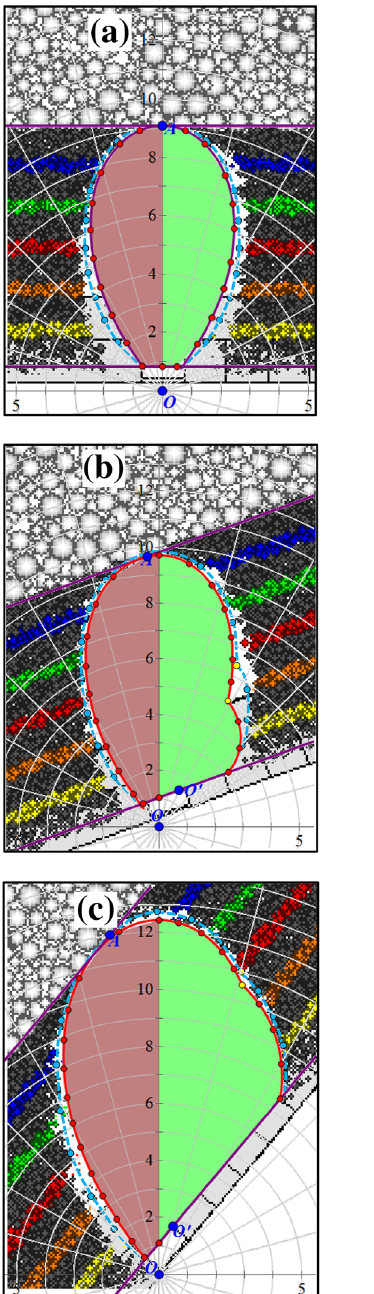
Fig. 12 Comparison of theoretical (red full curve) and numerically simulated (blue dashed curve) drawing body shapes in the initial drawing stage: a a = 0 (cid:3) ; b a = 20 (cid:3) ; c a = 50 (cid:3)